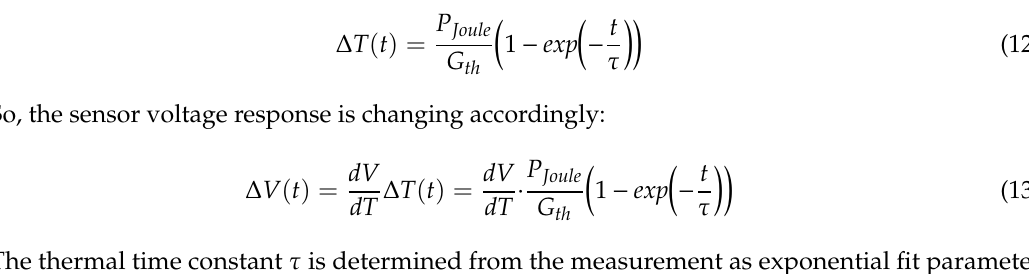
Figure 13. Transient measurements of the DUT voltage response to heating: ( a ) Current 4.2 mA is supplied to transistor; the thermal time constant is 7.3 msec. ( b ) Current 2.5 mA is supplied to heater; the thermal time constant is 8.2 msec. (Plate area 213.2 µ m × 213.2 µ m, arm width 6.4 µ m and a gap of 18 µ m, R heater = 1000 ohm ).